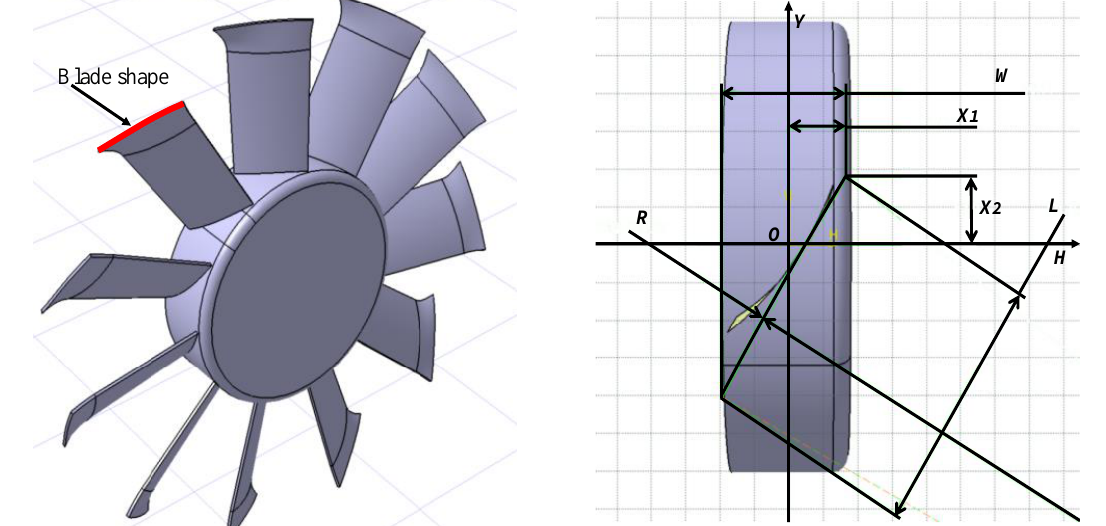
Figure 9. Schematic diagram of the design parameters of the fan for reliability optimization.